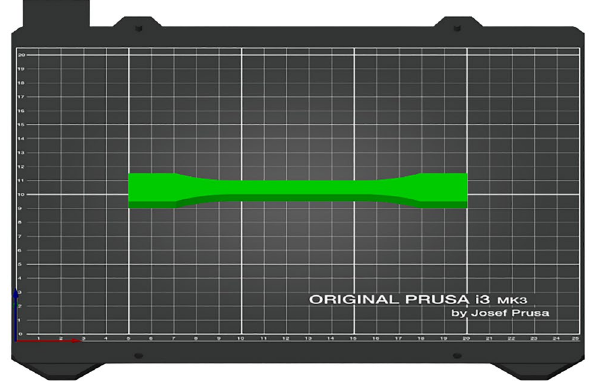
Fig. 6 Print orientation for the tensile test specimen